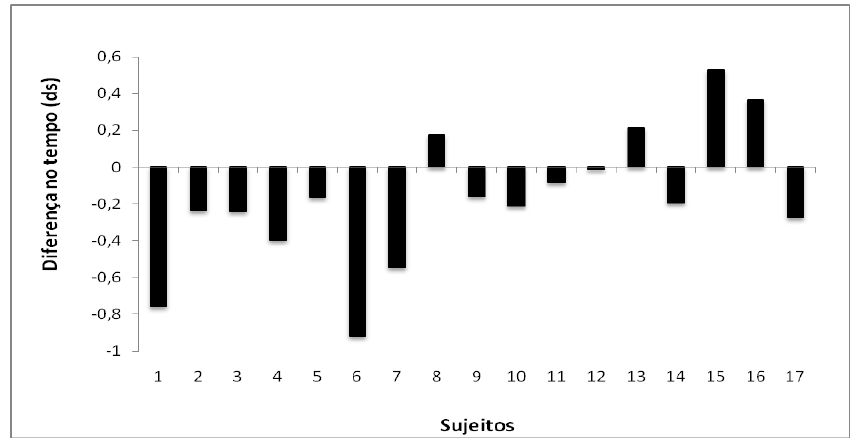
Figura 1. Diferença em décimo de segundo, entre a ingestão de placebo e cafeína no tempo final dos 200m rasos. (N =